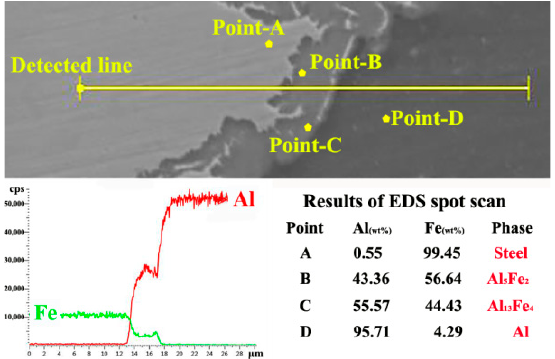
Figure 5. The results of EDS line scan and spot scan through the IMCs layer of UaFSW joint.